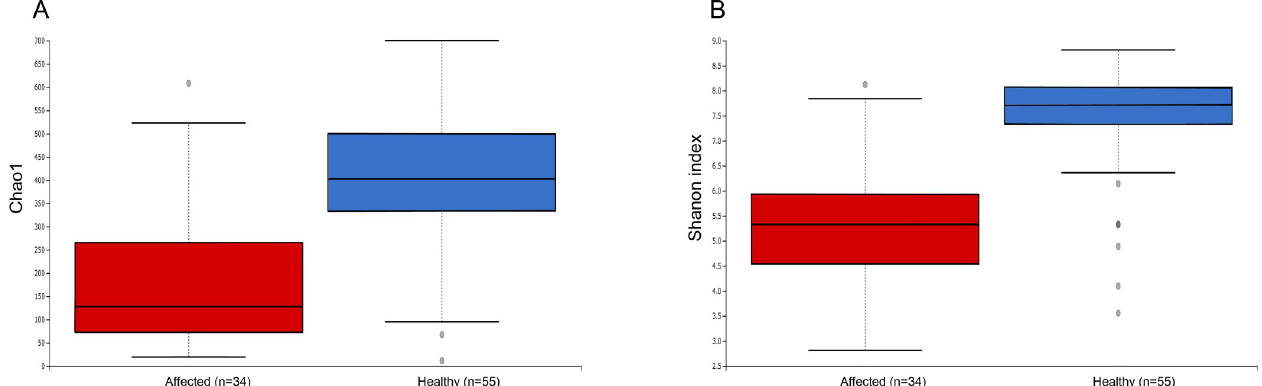
Fig 4. Alpha diversity analysis between healthy and affected dogs. Differences in alpha diversity metrics between healthy and affected dogs: (A) Chao1 index; (B) Shannon index.